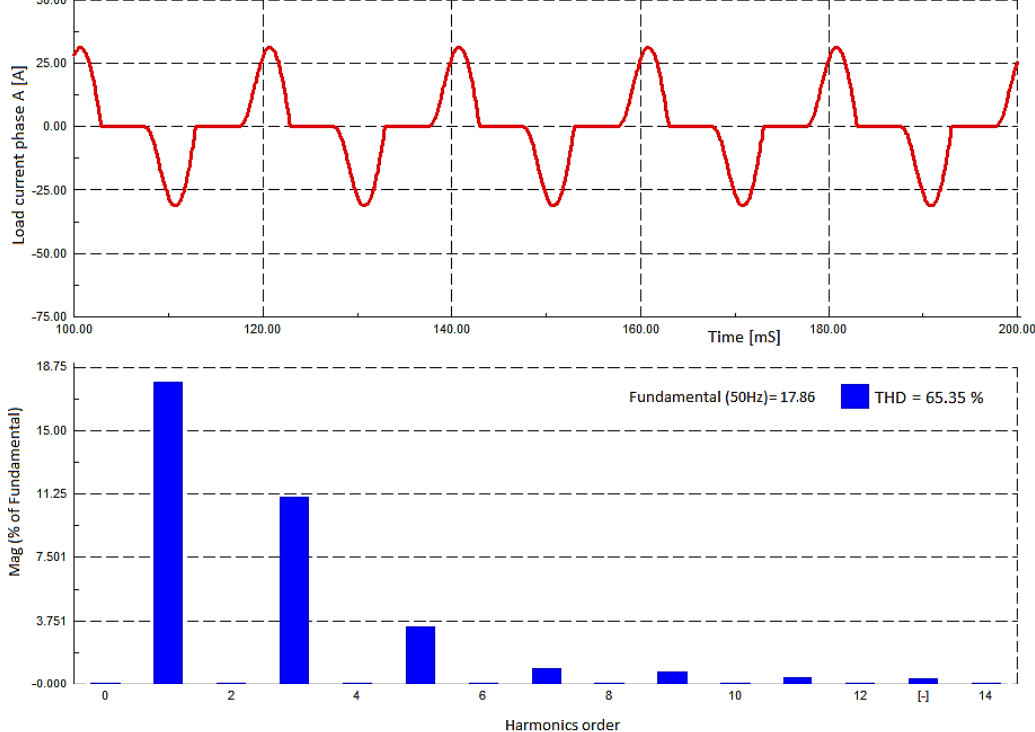
Figure 18. The waveform of load current and the associated current harmonic spectrum. THD: total harmonic distortion.